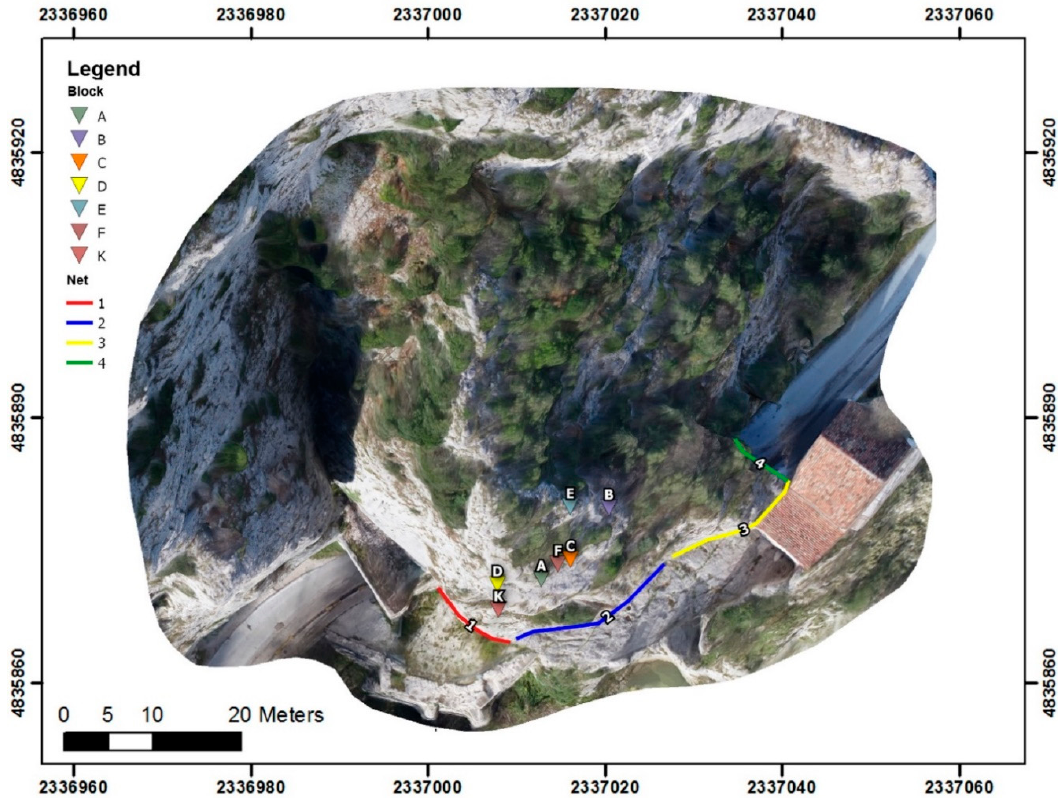
Figure 11. Scheme of virtual net counters. Table 6. Results of rockfall simulation with virtual net counters.